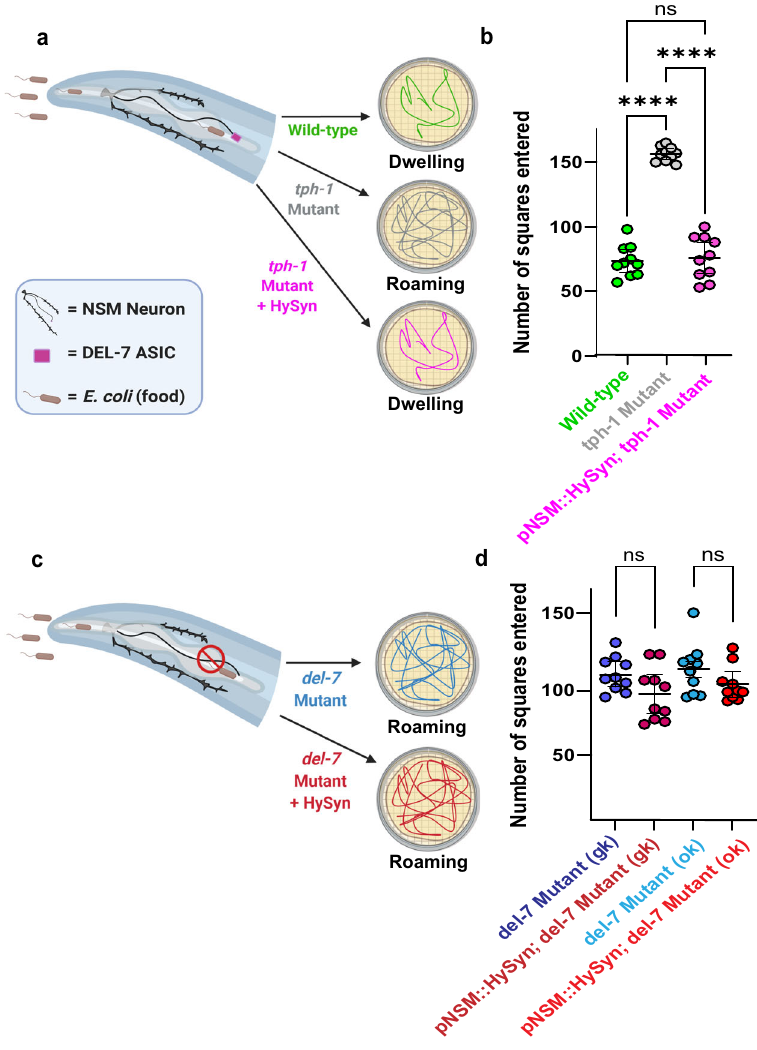
Fig. 4 Suppression of abnormal behavioral states via targeted reconstitution of HySyn neuromodulatory connections. a A schematic of a nematode head, and the pharyngeal, food-sensing enteric neuron NSM (black). NSM senses the presence of bacteria (food) via the DEL-7 acid-sensing ion channel (ASIC) receptor (purple box), and releases serotonin, resulting in a “ dwelling ” behavioral state in wild-type animals (green), which can be scored by quantifying animal displacement in the food-covered Petri dishes, as depicted in the schematic and described 30,32 . Mutant animals for serotonin biosynthesis, such as tph-1(mg280) 33 , are incapable of releasing serotonin and remain in a state of “ roaming ” even in the presence of food (gray). Reconstitution of circuit connectivity by using HySyn to connect serotonin-releasing NSM neuron and muscles. Note this con fi guration of HySyn can suppress the abnormal “ roaming ” state in tph-1(mg280) mutants. b Quanti fi cation of the roaming and dwelling phenotypes, as described 30,32 , for the indicated genotypes. Each dot in the graph represents an individual animal, and a total of ten animals were blindly scored per genotype ( p <0.0001 for tph-1 mutant vs. wild-type, p <0.0001 for tph-1 mutant vs. pNSM::HySyn; tph-1 mutant, n = 10 independent biological replicates for all groups). c As a , but for mutant animals lacking the del-7 receptor, which makes them incapable of sensing food. Note that these animals are wild-type for the serotonin biosynthetic pathway, but phenocopy serotonin mutant animals because the NSM enteric neuron is not activated in the presence of food 30,32 . d As b , but for two comparable alleles of del-7 ( n = 10 independent biological replicates for all groups). del-7(ok1187) (light blue) contains a deletion for the intercellular region of DEL-7, and del-7(gk688559) (dark blue) contains an early stop codon. Note that del-7 mutants display roaming behaviors, but that the reconstituted HySyn (dark and light red), as expected, is incapable of suppressing del-7 , as del-7 mutant animals are incapable of sensing food, incapable of activating NSM and therefore incapable of inducing the release of HyPep in the presence of food. This experiment demonstrates that the HySyn suppression of the tph-1 mutants results from the activity-dependent release of HyPep from NSM upon encountering food. One-way ANOVA followed by a Tukey ’ s multiple comparison post hoc test was used to compare the means of each group. * indicates p < 0.05, ns indicates that no statistically signi fi cant difference was observed. Error bars (black) represent the mean of each group and 95% con fi dence intervals. Schematics were made with BioRender 43 . Source data are provided as a Source Data fi